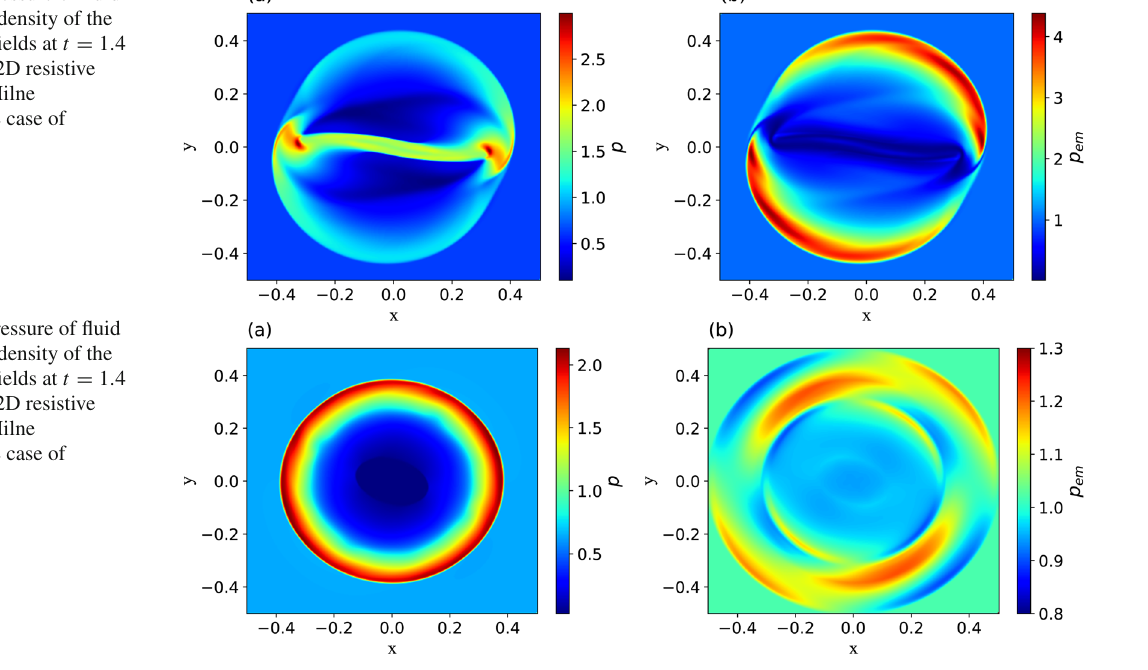
Fig. 12 a The pressure of fluid and b the energy density of the electromagnetic fields at t = 1 . 4 are shown in the 2D resistive rotor test in the Milne coordinates in the case of σ = 10 3